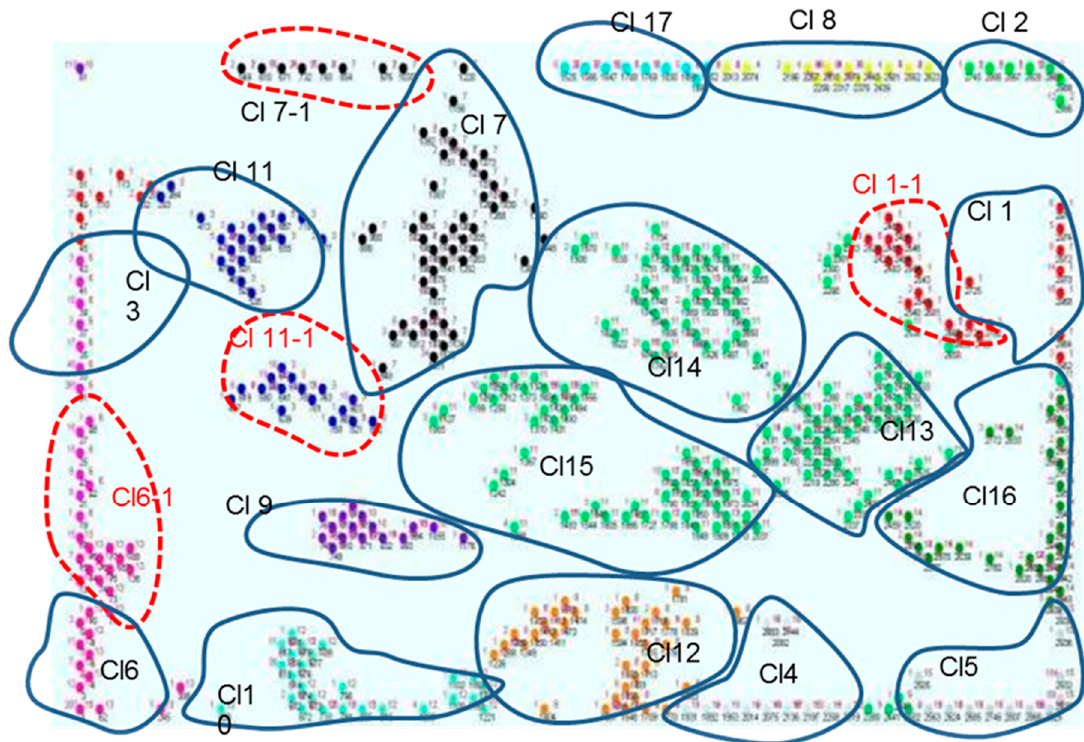
Figure 4. Cluster identification on the basis of the Sm and Ss indices.